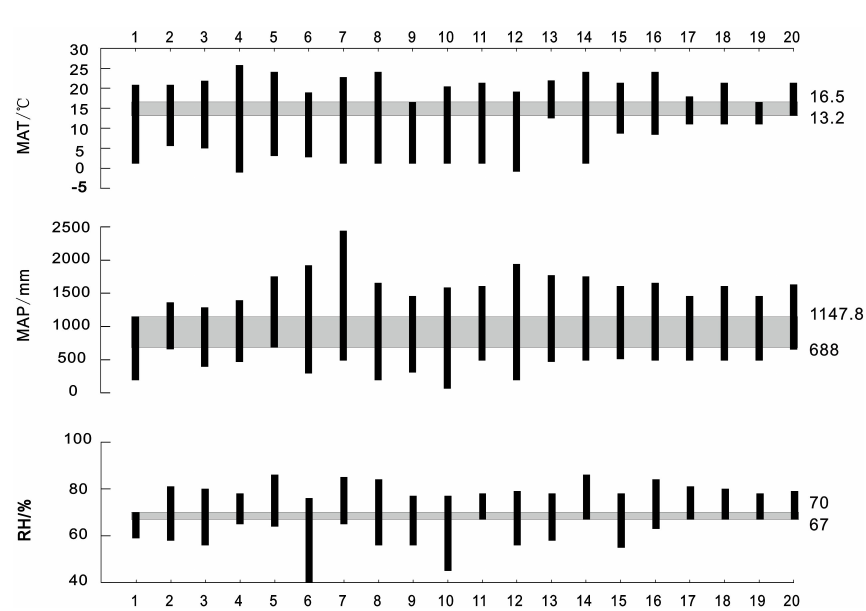
Fig. 7. Coexistence intervals for the Xishanping section. 1. Picea sp.; 2. Pseudotsuga sinensis ; 3. Castanea sp.; 4. Quercus sp.; 5.